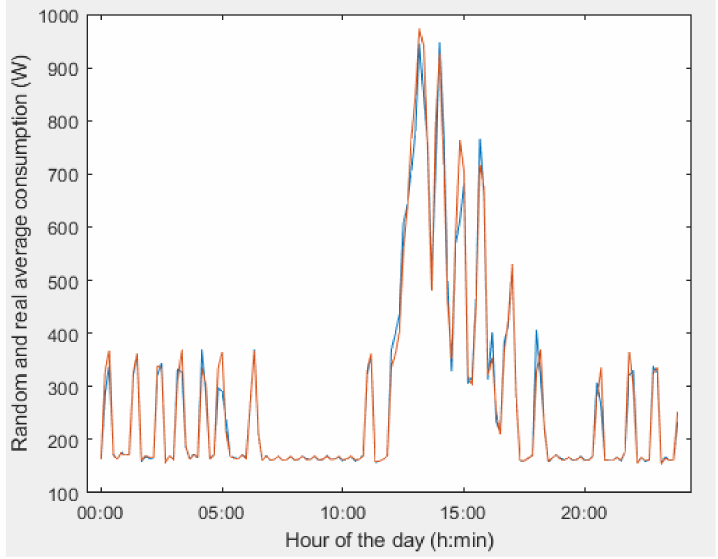
Figure 11. Random (blue) and real (orange) average consumption of HVAC during